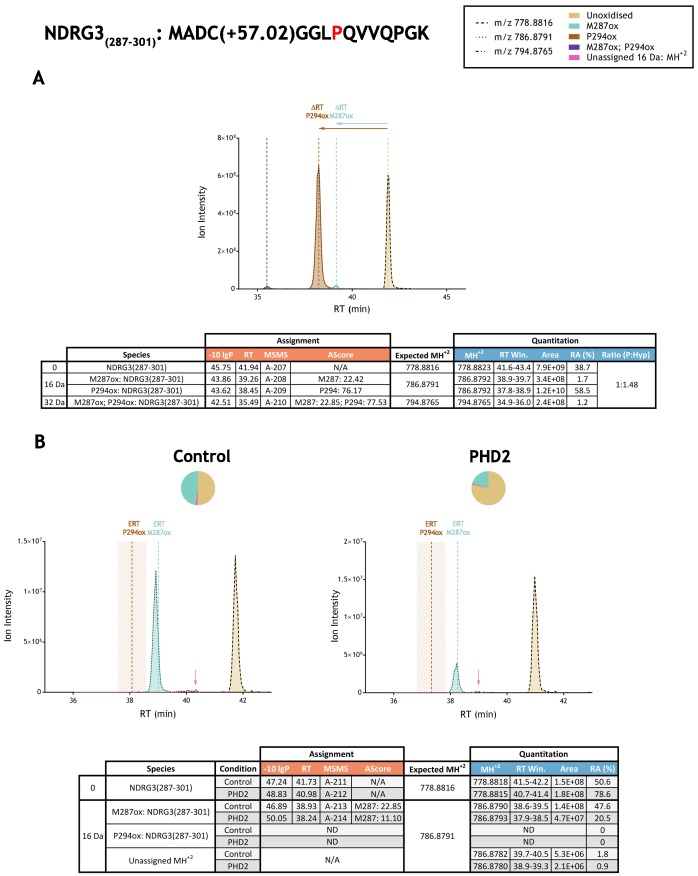
Quantitation of peptide oxidation on NDRG3(287–301) following reaction of N-terminally truncated NDRG3 (residues 108–375) with recombinant PHD2.XIC data presented in (A) shows ion intensity and retention time (RT) characteristics of equimolar synthetic peptide standards for unoxidised and P294ox forms of the tryptic NDRG3(287–301) peptide. MSMS assigned species including non-enzymatic oxidations are coloured (see inset); vertical dashed lines define peak maxima used to derive ΔRT values for key oxidised ions. (B) Shows comparable XIC data for protease-digested IVTT substrate under control (left) or PHD2-reacted (right) conditions. Peaks corresponding to unoxidised and M287ox forms of NDRG3(287–301) were assigned by MSMS (see inset for colour code); P294ox was not detected. Estimated RT (ERT) values for oxidised peptides, derived from (A), are indicated by dashed vertical lines, shading applied to ERT P294ox corresponds to a 1 min RT window. Peptide ions of low abundance that were compatible with oxidation but not assigned by MSMS are also indicated (pink arrow). Quantitative data for observed species are presented as pie charts with XIC data. Assignment and quantitative data is provided below each panel as follows: (−10lgP) significance score of leading assignment at given (RT) with ambiguity score (AScore) for PTM localisation and reference to primary MSMS data in Supplementary file 1. Quantitative data reports ion counts (Area) of observed masses (MH+2) integrated over time (RT Win.), expressed as relative abundance (RA). Data on detection efficiency for synthetic peptides (Panel A, P: Hyp) is an aggregated ratio of prolyl (P) to hydroxyprolyl (Hyp) species.